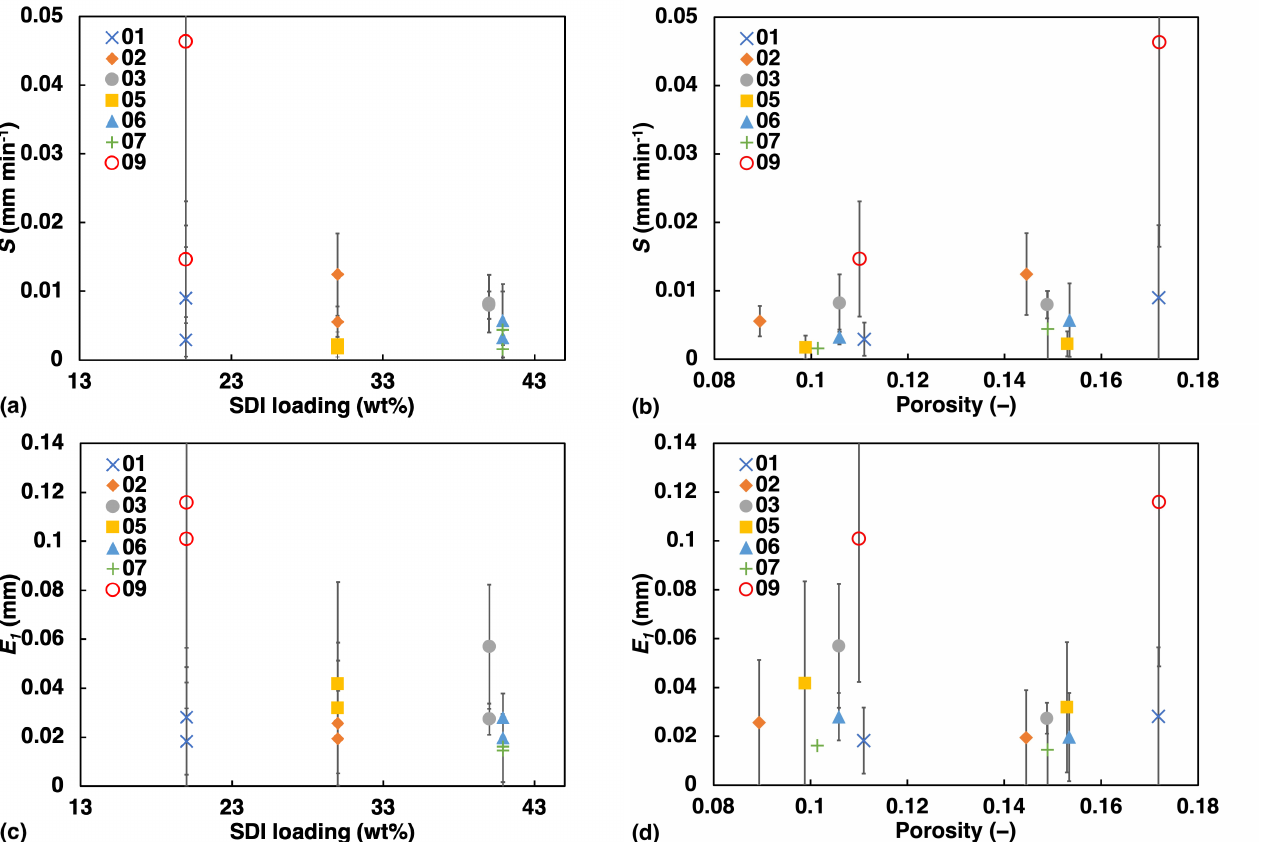
Figure 7. Apparent swelling rate S ( a , b ) and the extent of swelling E 1 ( c , d ) at 1mm liquid penetration against: Left: SDI, Right: